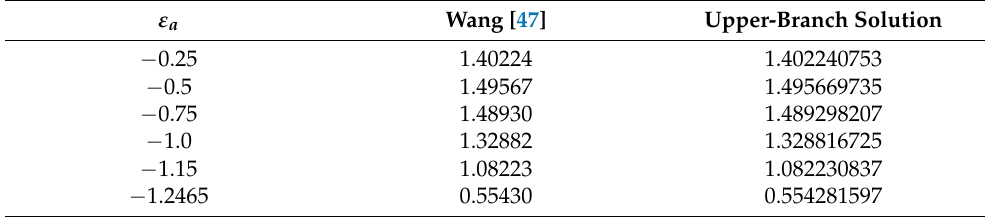
Table 3. Comparison values of the friction factor for several values of the shrinking parameter ε a . ε a Wang [47] Upper-Branch Solution − 0.25 1.40224 1.402240753 − 0.5 1.49567 1.495669735 − 0.75